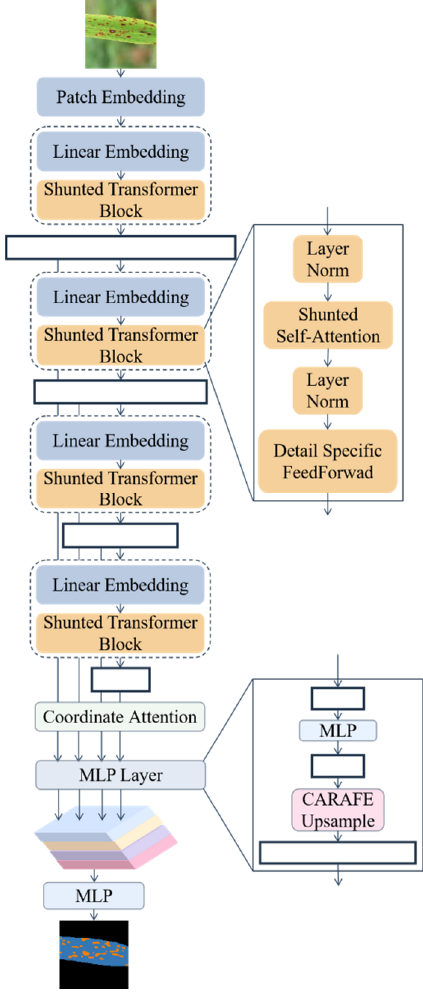
Figure 5. The overall architecture of the RSegformer network.